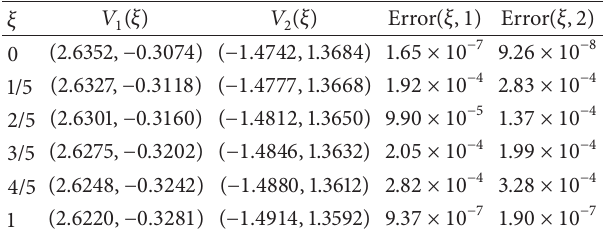
Table 2: Solution and relative error for Example 2.